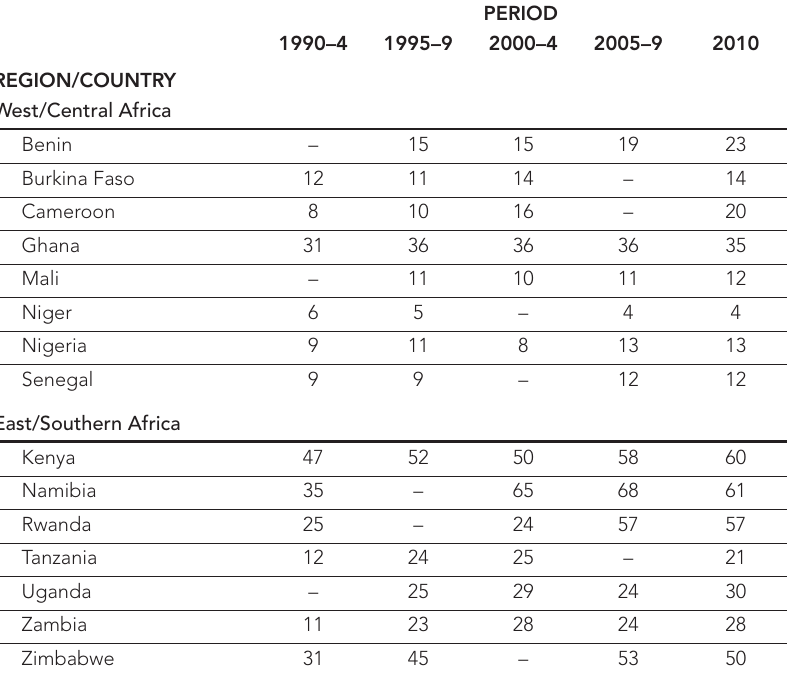
Table 2: Among women with three living children, percentage who want no more PERIOD 1990–4